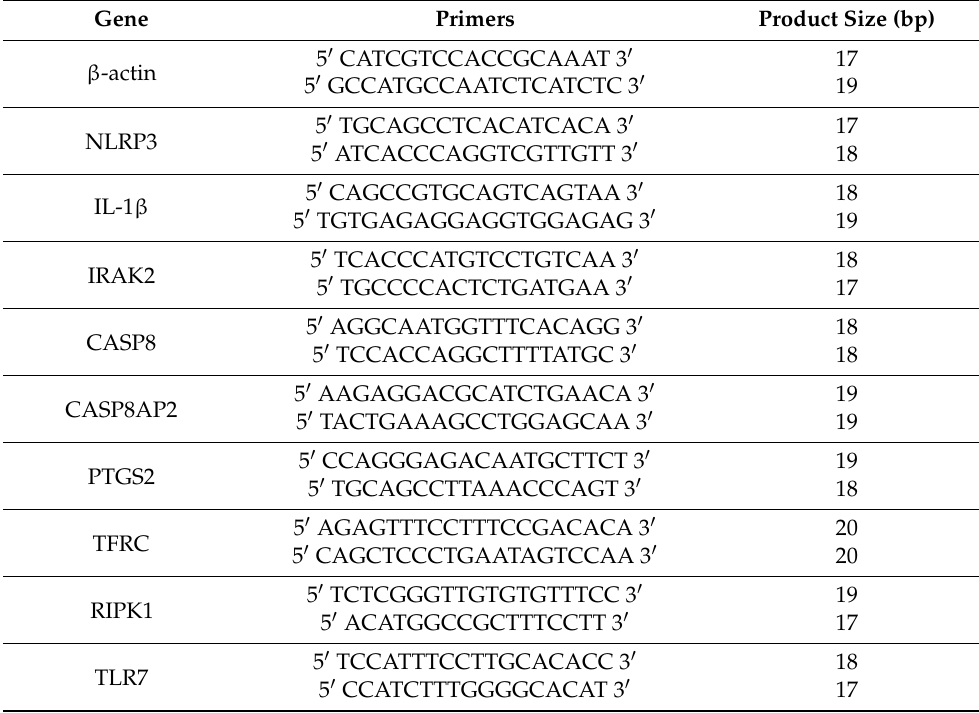
Table 1. Details of primers used for qRT-PCR validation of